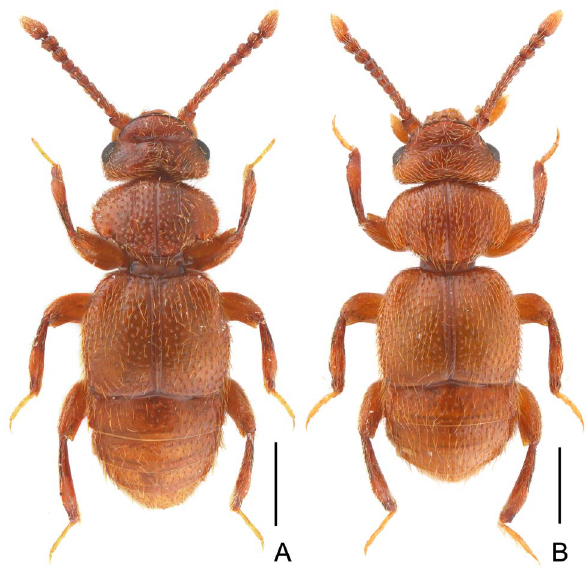
Figure 1. Habitus of Bryantinusmatangus . (A) Male. (B) Female. Scales: 0.5 mm.